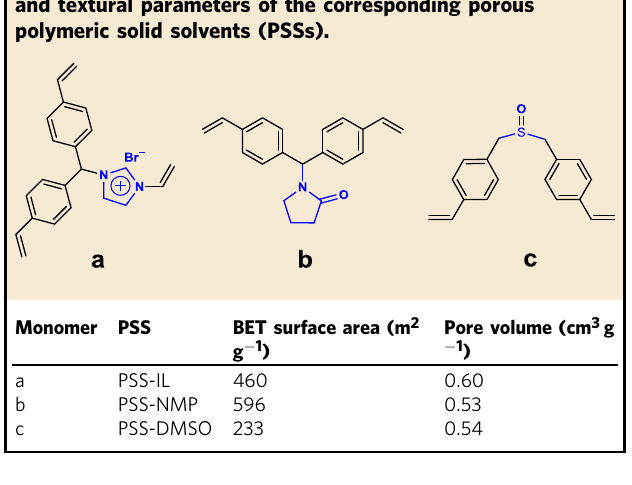
Table 1 Structures of vinyl-functionalized solvent moieties and textural parameters of the corresponding porous polymeric solid solvents